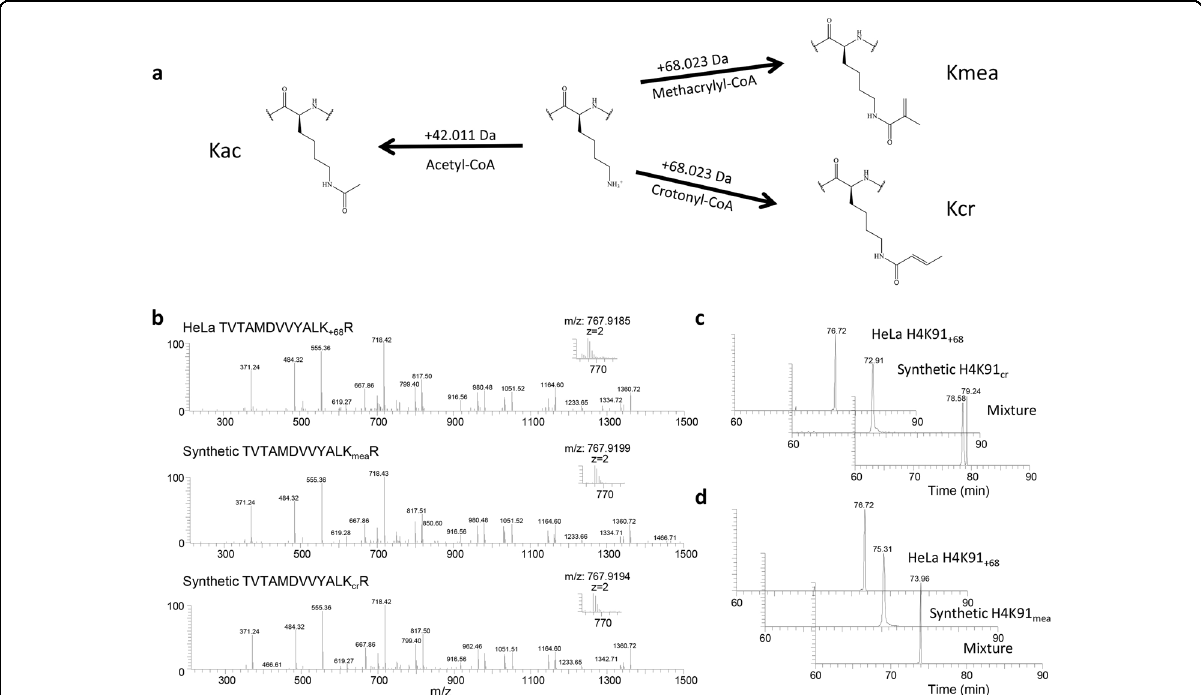
Fig. 1 Identi fi cation and veri fi cation of lysine methacrylation (Kmea). a Lysine (center) is capable of being modi fi ed with multiple different PTMs depending on which acyl-CoA is used in the enzymatic reaction. The appropriate acyl-CoAs as well as the associated mass shift added to a lysine residue is indicated for acetyllysine (left), methacryllysine (Kmea, upper right), and crotonyllysine (Kcr, lower right). b MS/MS spectra of an exemplary HeLa histone peptide (top), synthetic H4K91ma peptide (middle), and synthetic H4K91cr peptide (bottom). c Extraction ion chromatograms of HeLa cells-derived histone peptide (TVTAMDVVYALK + 68 R) (top), synthetic H4K91cr peptide (middle), and a mixture of the two peptides (bottom). d Extraction ion chromatograms of HeLa cells-derived histone peptide (TVTAMDVVYALK + 68 R) (top), synthetic H4K91mea peptide (middle), and a mixture of the both peptides